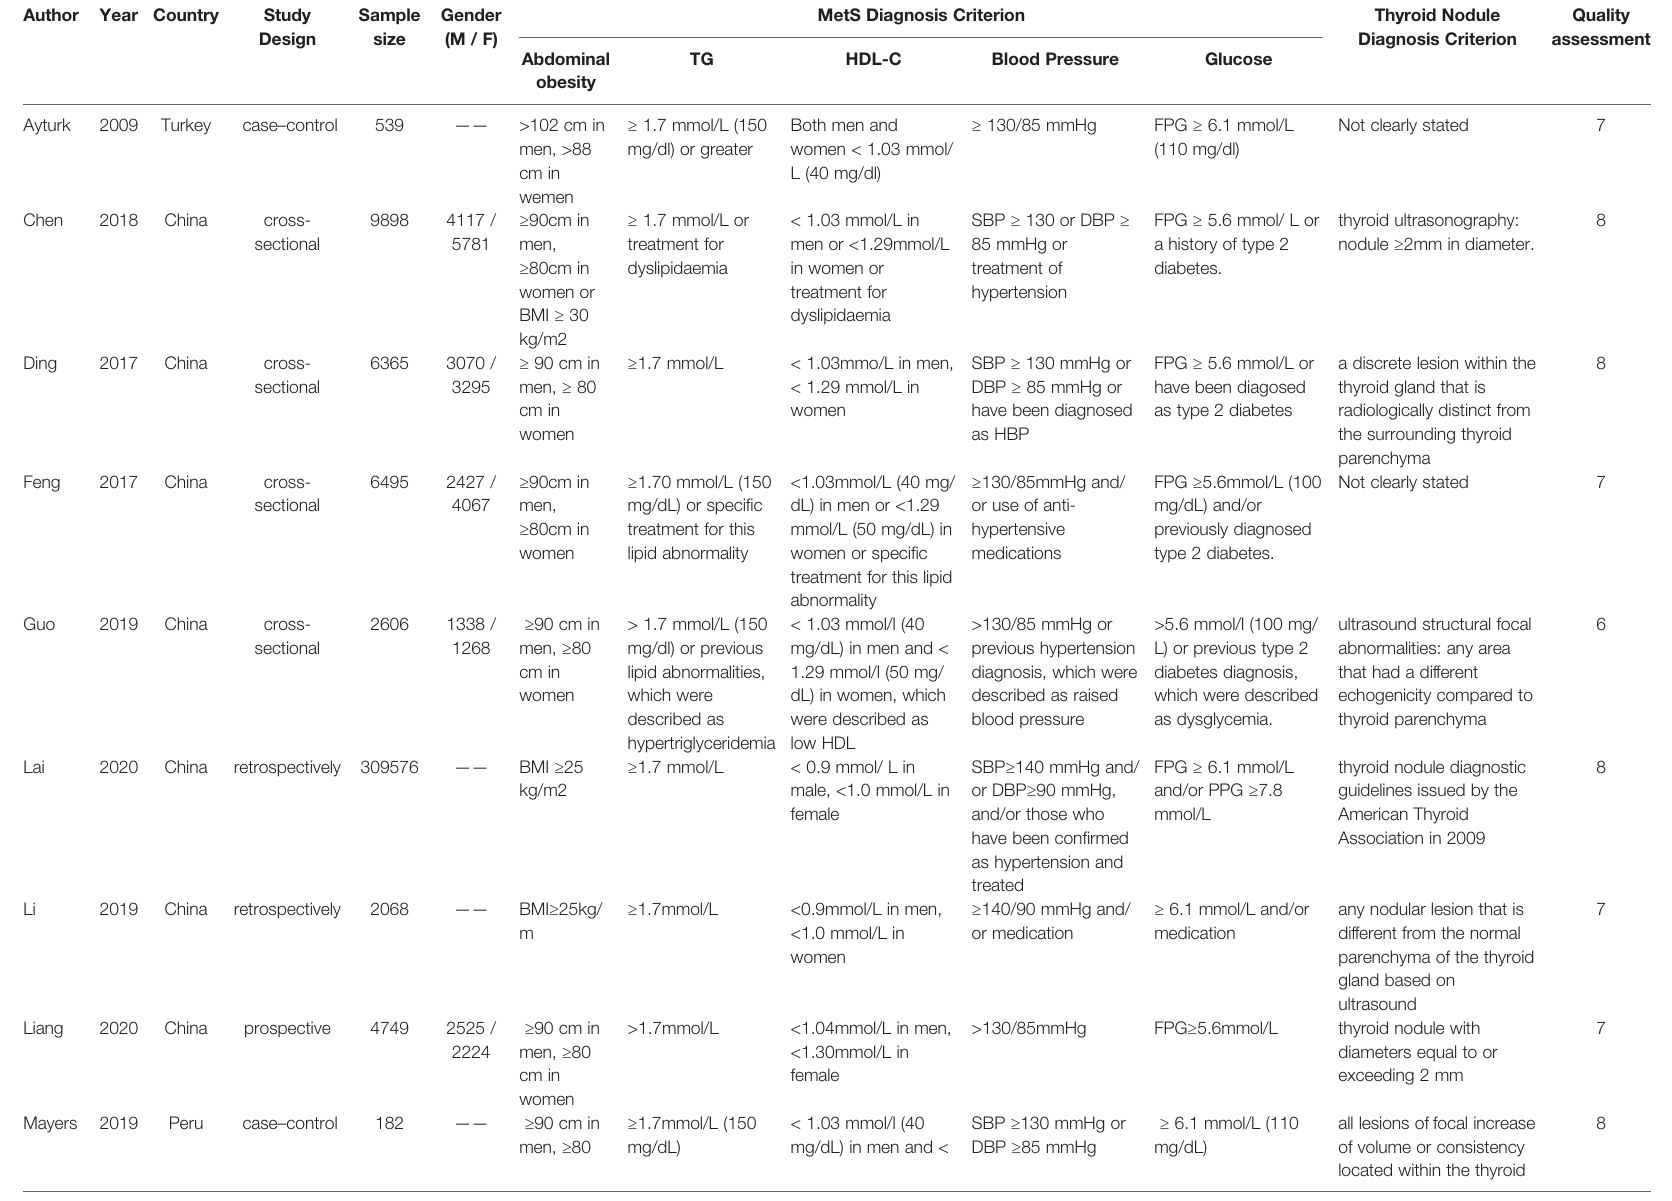
TABLE 2 | Characteristics and diagnosis criteria of the 15 included studies. Author Year